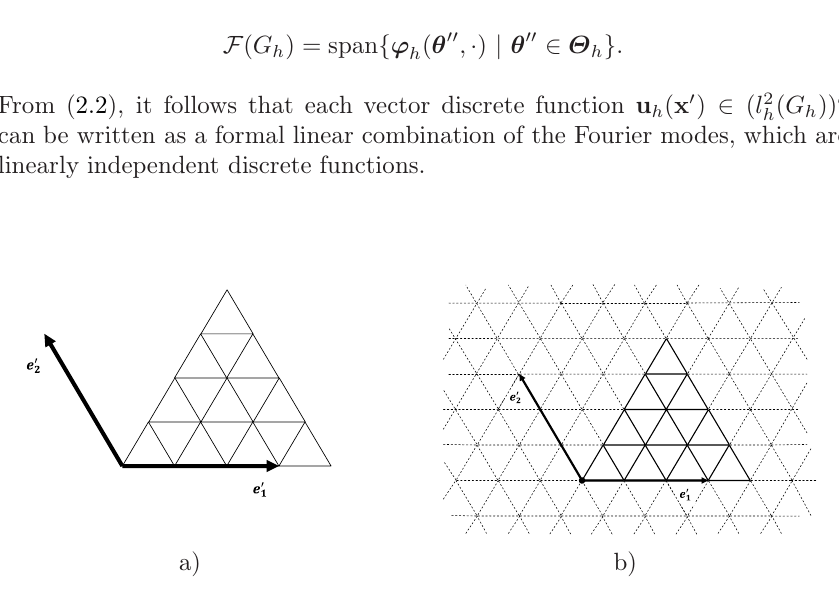
Figure 2. Grids: a) regular triangular grid on a fixed coarse triangle T , b) its extension to an infinite